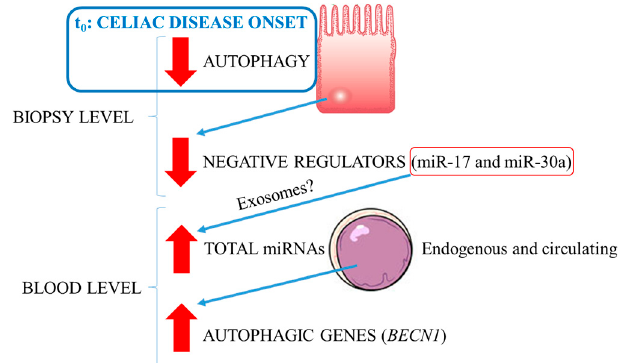
Figure 10. Interpretative model of autophagy modulation as inferred by ATG s’ and miRNAs’ expression profiles in the intestine (biopsy level) and in the blood of CD patients. Red arrows define autophagy status (i.e. down-regulation or up-regulation).